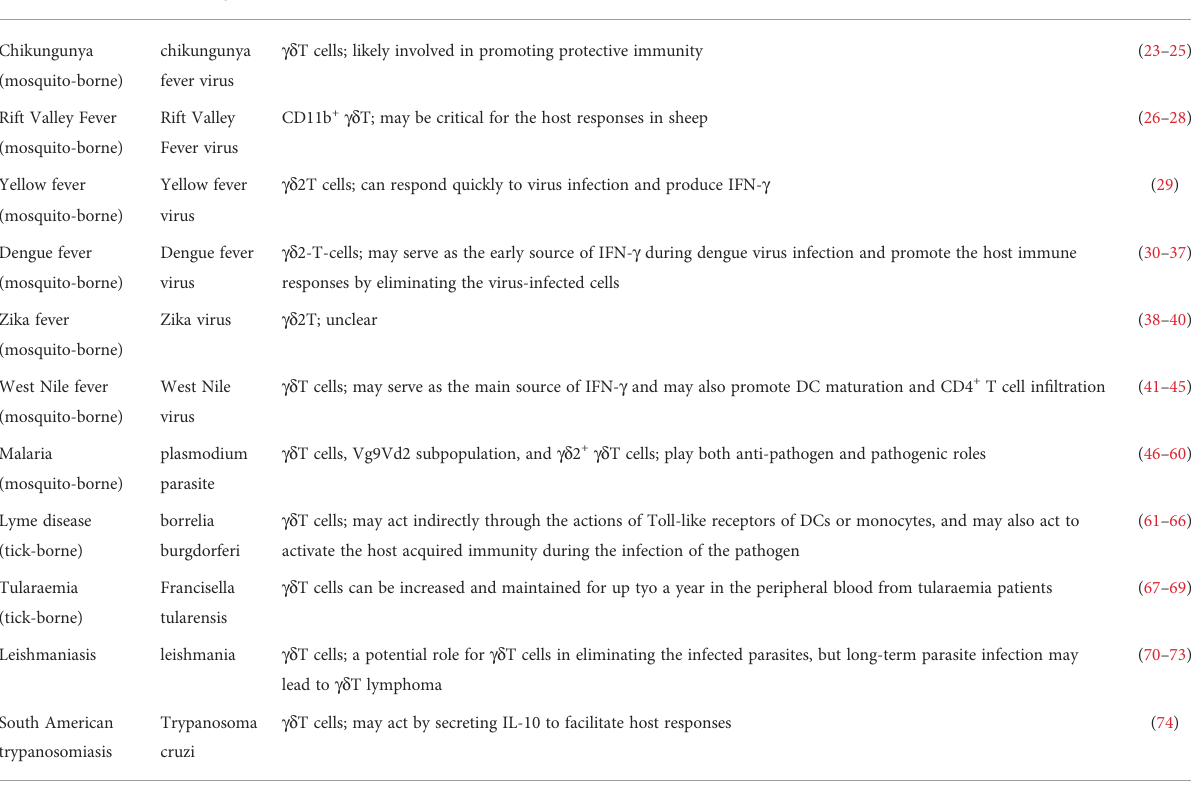
TABLE 1 Potential roles for gd T cells in vector-borne diseases.